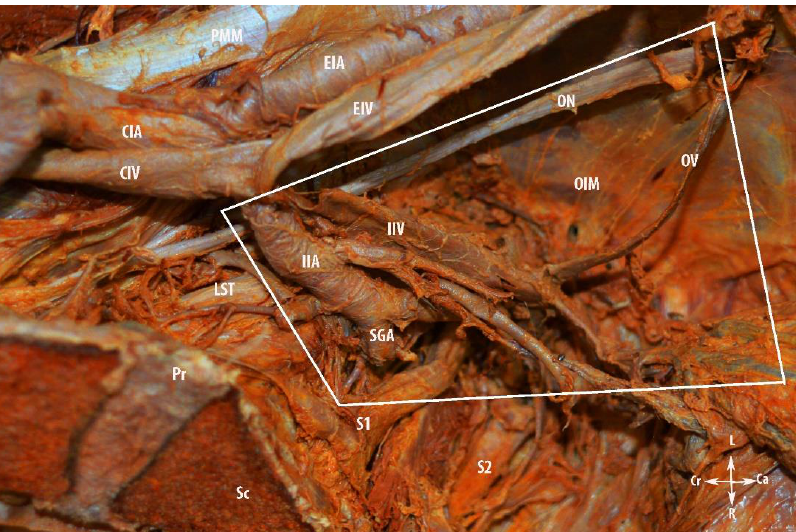
Figure 6. Limits of the vascular region of the pelvic sidewall. PMM — psoas major muscle; CIA —